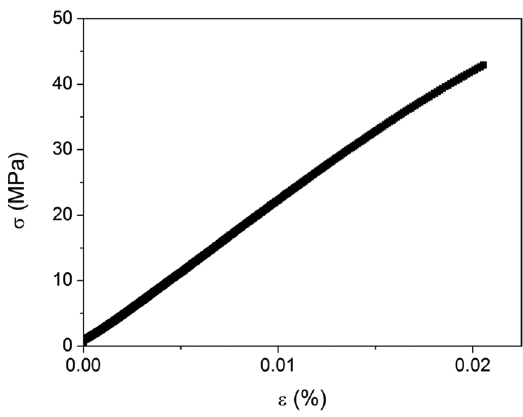
Figure 6. Stress-strain curve obtained from mechanical test of LY sample. Table 4. Young’s modulus (E) and tensile strength (σ values obtained by mechanical tests. Values between parentheses are the standard deviation with α =